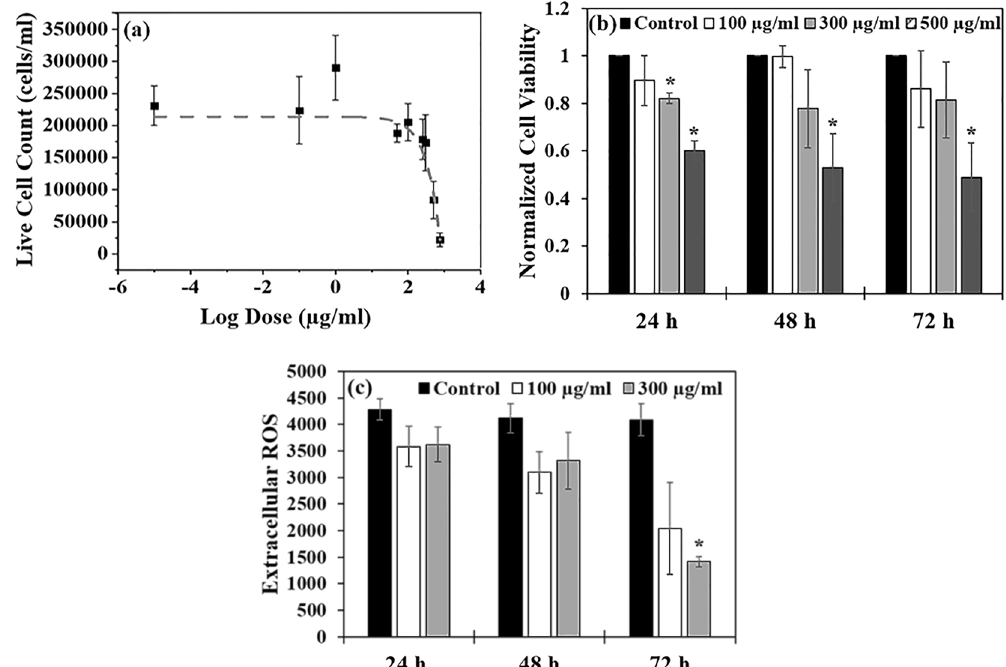
Figure 4. ( a ) Dose response curve (based on live cell counts) for BEAS-2B cells exposed to PLACC900 from 0–750 µ g/ml (n = 5). The data was fit via a sigmoidal curve using OriginPro (OriginLab Corporation) software. ( b ) Cellular viability (based on WST assay) for cells exposed to PLACC900 (n = 6). The symbol * indicates a significant difference between the control cells and exposed cells. The values are normalized relative to the controls. ( c ) Extracellular ROS of cells exposed to varying doses of PLACC900 (n = 4). The symbol * indicates a significant difference between the control cells and exposed cells. Significance was determined by one-way analysis of variance ANOVA with p < 0.05, * indicating significance.